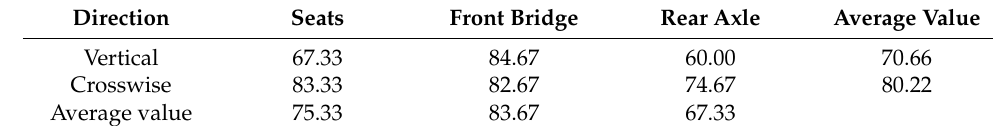
Table 7. Recognition accuracy of backpropagation (%).